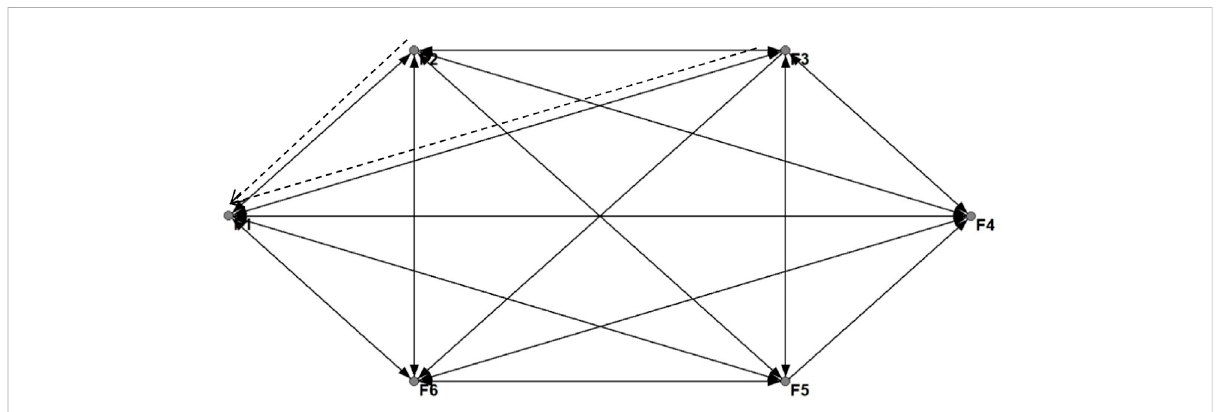
Collective FCM. Source: own elaboration.